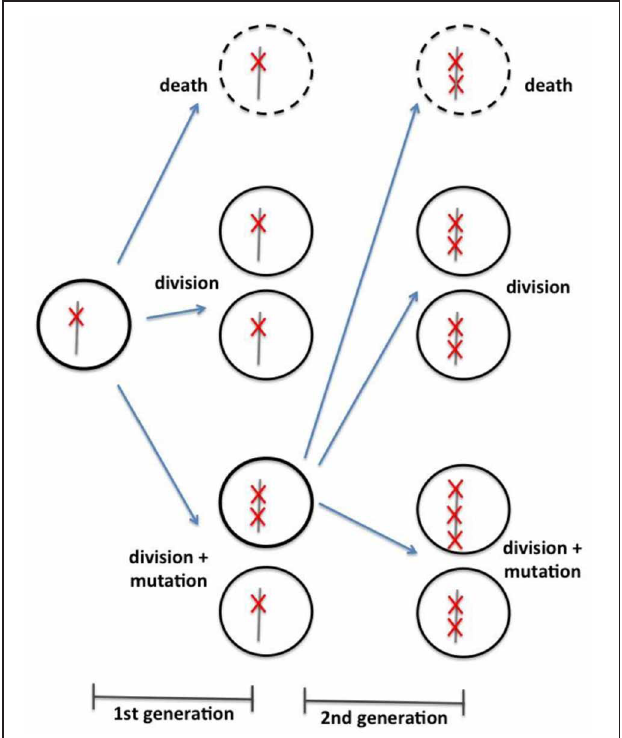
FIGURE 1 | Schematic representation of branching process model of cell division, as proposed by Bozic et al. (2010). According to a specific probabilistic distribution, each cell can either (1) die, (2) divide without acquisition of a new mutation, or (3) divide with acquisition of a new driver